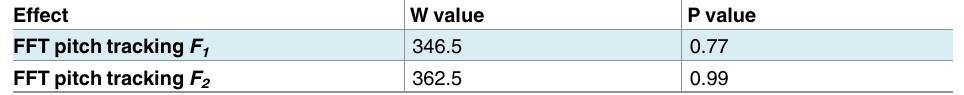
Table 5. Mann-Whitney-Wilcoxon test for first and second formant pitch tracking between musicians and